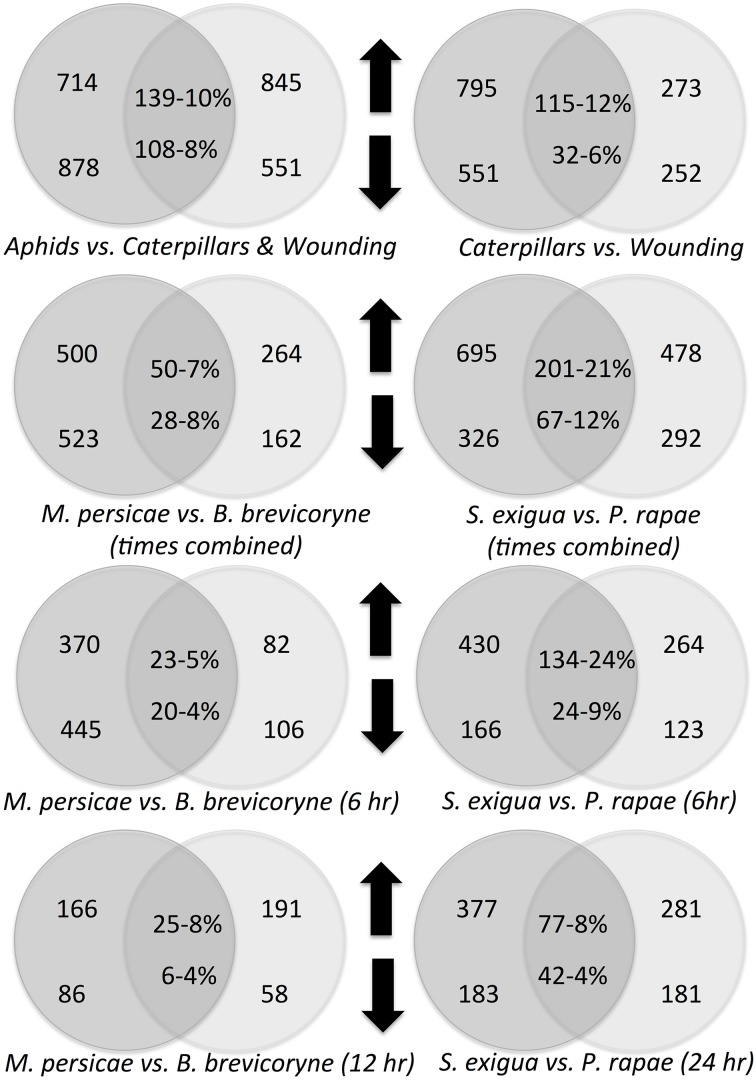
Treatment comparisons with the number of genes differentially expressed in each treatment, the number of genes expressed in both treatments, and their proportional overlap. Upward pointing arrows indicate upregulated genes, downward pointing arrows indicate downregulated genes.